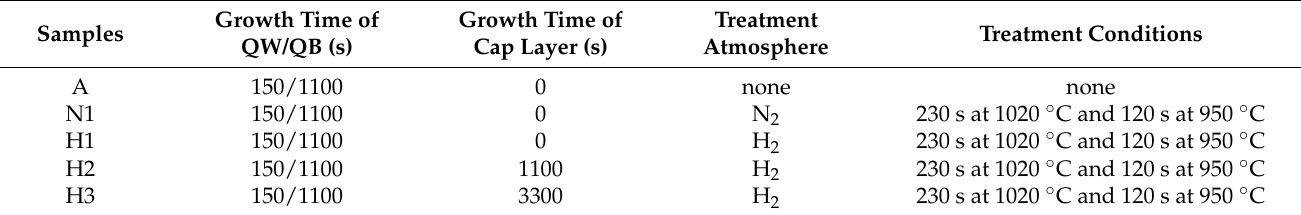
Table 1. Growth and heat treatment conditions of